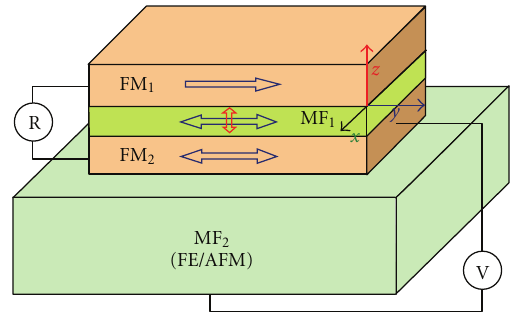
Figure 9: Schematic design of the proposed eight-logic memory cell. MF indicates multiferroic and FM represents ferromagnetic layers. Figures were reproduced with permission from Yang et al.